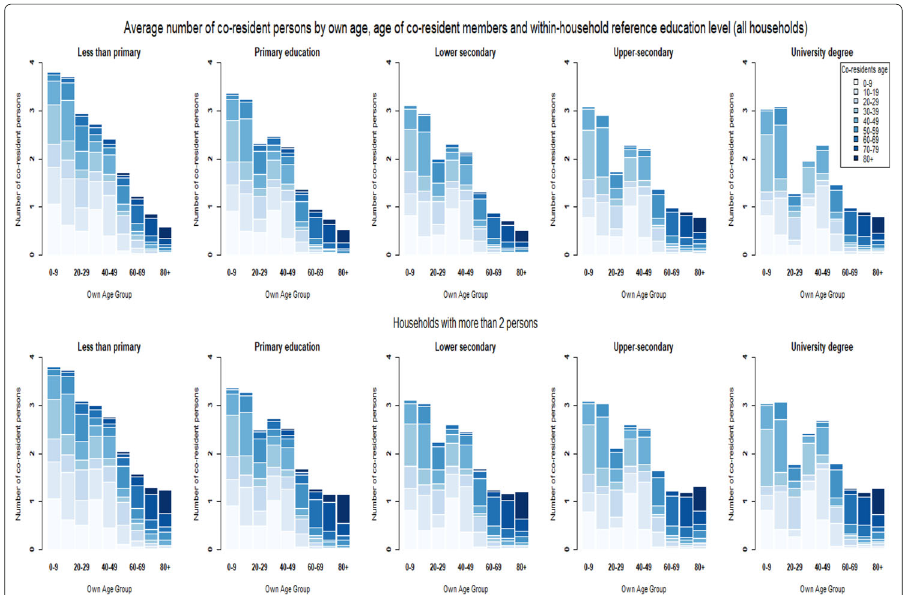
Fig. 8 Household structures by head-of-household education